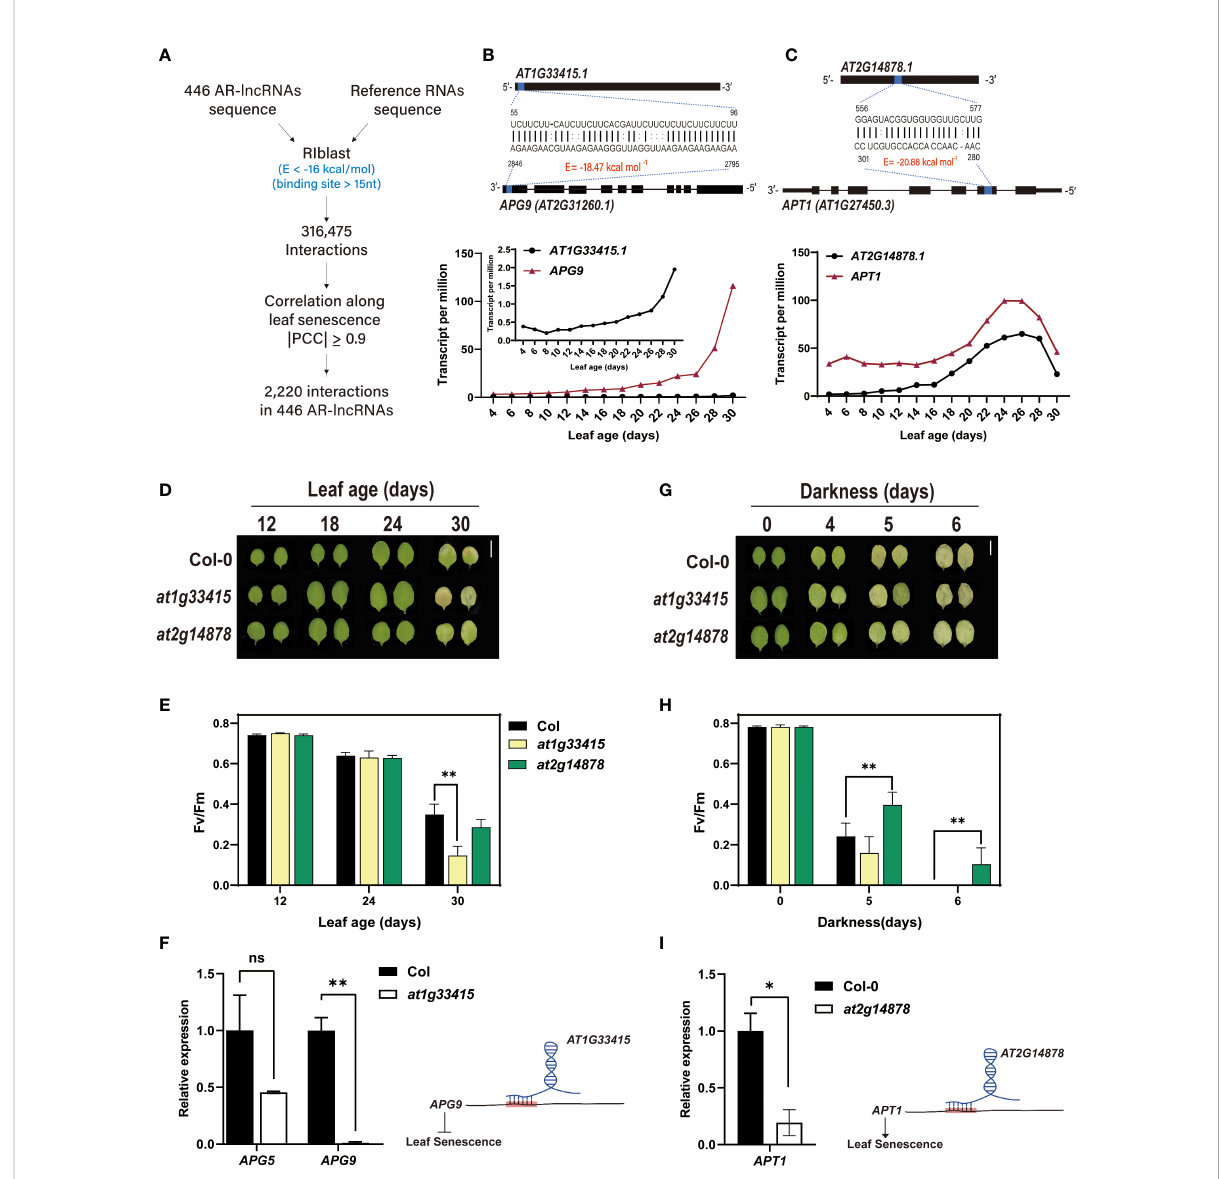
FIGURE 5 Prediction and validation of leaf senescence-regulating AR-lncRNAs. (A) Computational pipeline for the prediction of putative AR-lncRNA-RNA interactions. Interaction energy ( E , kcal/mol) of AR-lncRNA-RNA pairs was calculated using RIBLAST 1.1.1. Expression correlation along leaf aging was used to reduce the number of AR-lncRNA-RNA pairs, resulting in the identi fi cation of 2,220 candidate pairs (|PCC| ≥ 0.9). (B, C) Interaction between AT1G33415 and APG9 (B) and between AT2G14878 and APT1 (C) (upper panel), and age-dependent expression patterns of AT1G33415 and APG9 (B) and AT2G14878 and APT1 (C) (lower panel). Expression levels were expressed as the mean TPM values of two biological replicates. (D, E) Leaf yellowing phenotype (D) and F v /F m ratio (E) of the third and fourth rosette leaves of at1g33415 and at2g14878 mutants during natural leaf senescence. Error bars represent standard deviation (SD; n = 4). Asterisks indicate signi fi cant differences between the indicated groups (t- test; **, p < 0.01). (G, H) (G) Leaf yellowing phenotype (G) and (H) F v /F m ratio (H) of at1g33415 and at2g14878 mutants subjected to dark- induced leaf senescence. Error bars represent SD ( n = 6), and asterisks indicate signi fi cant differences between the indicated groups (t-test; **, p < 0.01). (F) Expression analysis of APG5 and APG9 in wild-type (Col-0) and at1g33415 leaves by qRT-PCR (left), and AT1G33415 -mediated suppression of leaf senescence potentially through interaction with APG9 mRNA (right). (I) Expression analysis of APT1 in wild-type (Col-0) and at2g14878 leaves by qRT-PCR (left), and AT2G14878 -mediated acceleration of leaf senescence potentially through the stabilization of APT1 mRNA (right). In (F) and (I) , data in the left panel represent the mean of two replicates, and error bars represent SD ( n = 2). Asterisks indicate signi fi cant differences (t-test; ns, non-signi fi cance; *, p < 0.05; **, p <